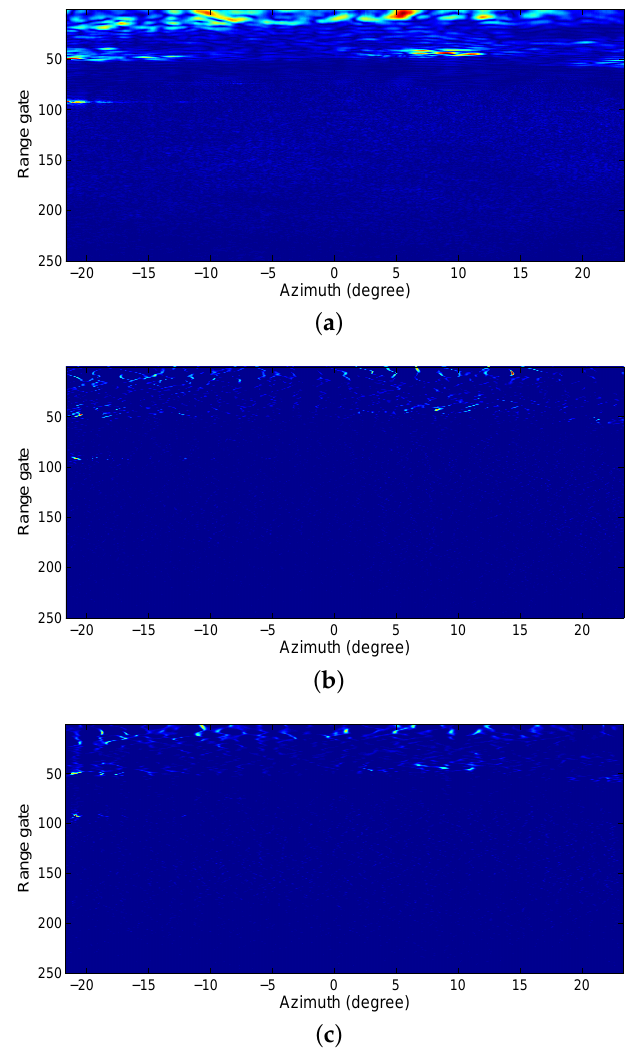
Figure 13. Real radar data of sea surface and coastline. ( a ) Original real radar data; ( b ) Result processed by MMAP; ( c ) Result processed by proposed